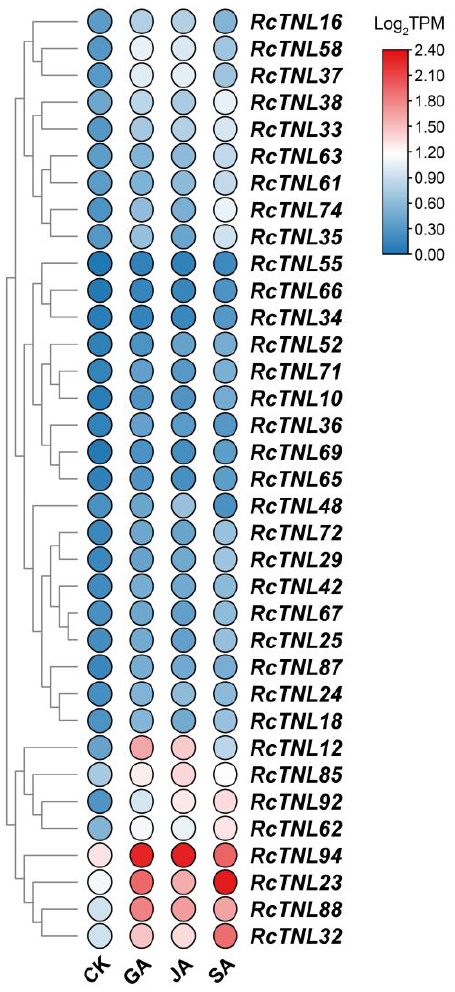
Figure 8. Heatmap of RcTNL genes differentially expressed in ‘Samantha’ petals after hormone treatment. CK denotes treatment with deionized water (the control), and GA, JA, and SA denote treatment with gibberellin, jasmonic acid, and salicylic acid, respectively. The change in color of the circles from blue to red indicates the change in the log 2 TPM values from low to high.